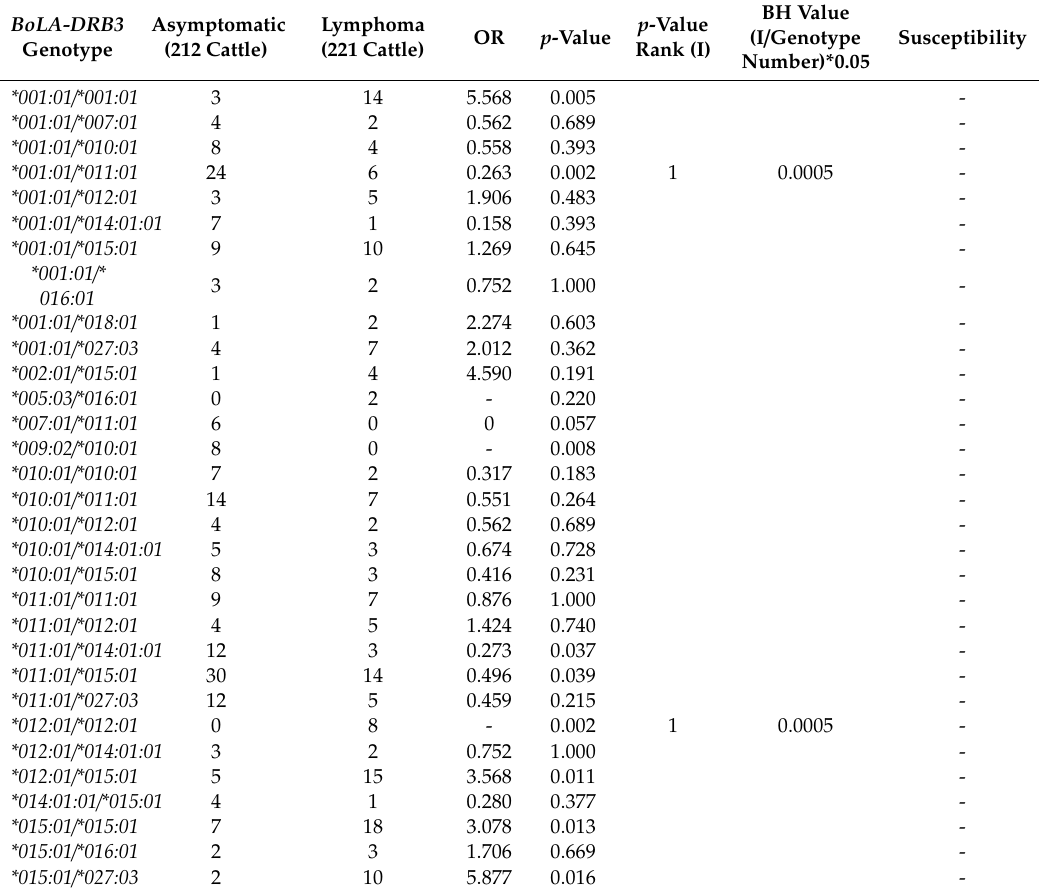
Table 4. Fisher’s exact test based association analysis of BoLA-DRB3 genotypes in asymptomatic and lymphoma